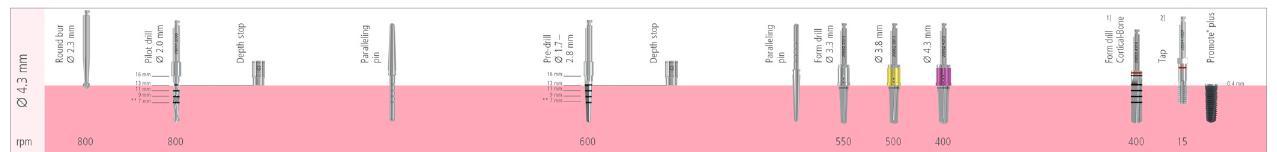
Figure 3. Drilling protocol for Camlog Screw-Line, Promote ® plus (with kind approval: Camlog Biotechnologies AG, Basel, Switzerland).